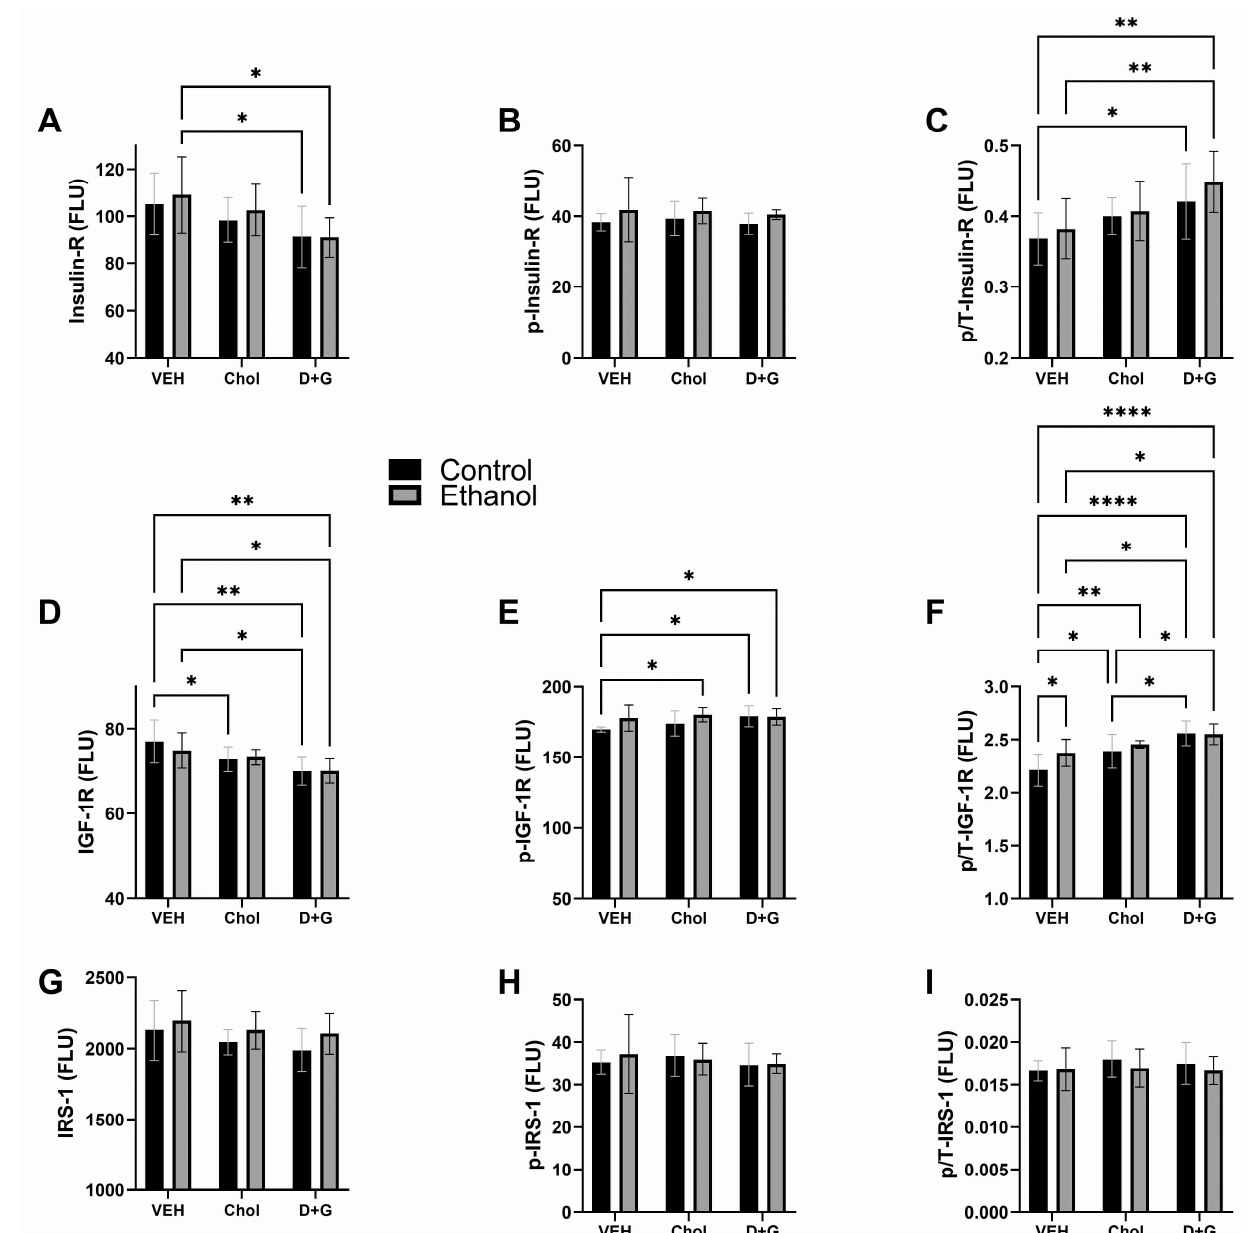
Figure 3. Ethanol and treatment (Chol and D+G) effects on upstream Insulin/IGF-1-Akt-mTOR pathway molecules. ( A ) Insulin R, ( B ) pYpY1162/1163 -Insulin-R, ( C ) p/T-Insulin-R, ( D ) IGF-1R, ( E ) pYpY1135/1136 -IGF-1R, ( F ) p/T-IGF-1R, ( G ) IRS1, ( H ) pS636 -IRS-1, and ( I ) p/T-IRS1. Graphs depict the mean ± SD of results (N = 6 cultures/group; FLU = fluorescent light units). Inter-group differences were analyzed by two-way ANOVA (see Table 2) with post-hoc multiple comparisons using Tukey tests. * p < 0.05;